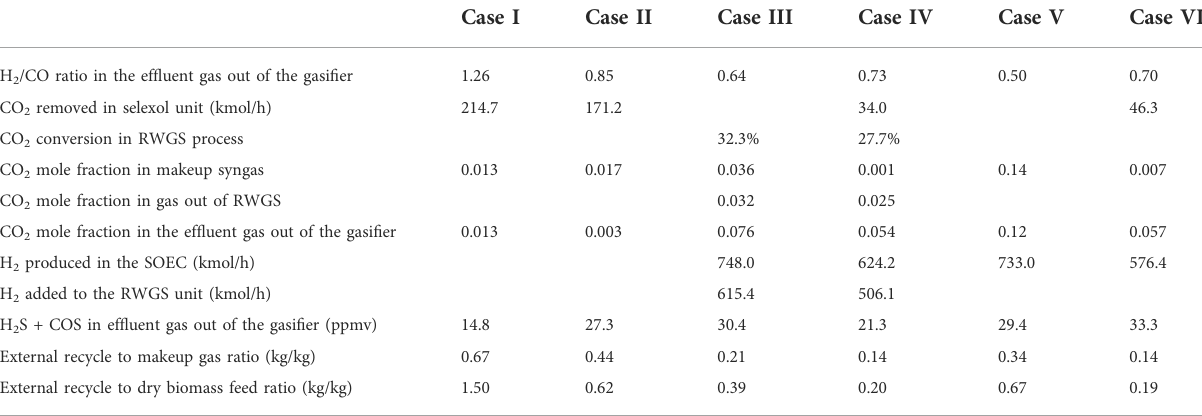
TABLE 3 Key technical results of the simulation in EF-gasi fi er.